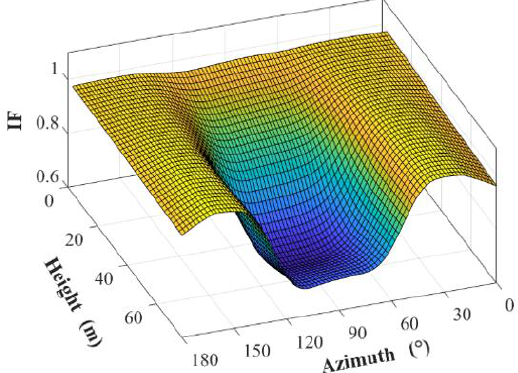
Figure 21. IF for peak deformation of boom-down 3# crane.